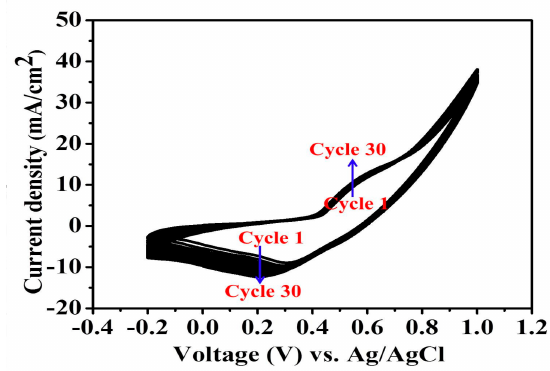
Figure 7. Consecutive CV of NiCu-CNF electrodes in 1 M KOH solution at 50 mV / s for 30